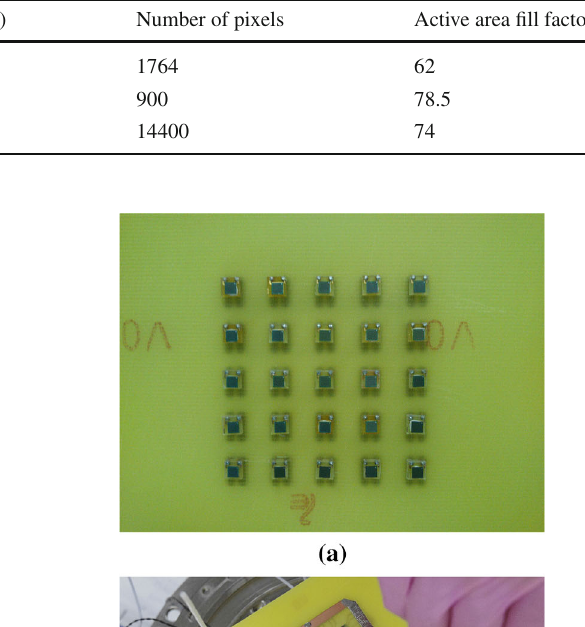
Table 1 Characteristic properties of three SiPMs types used in SiPM matrices SiPM type (producer)